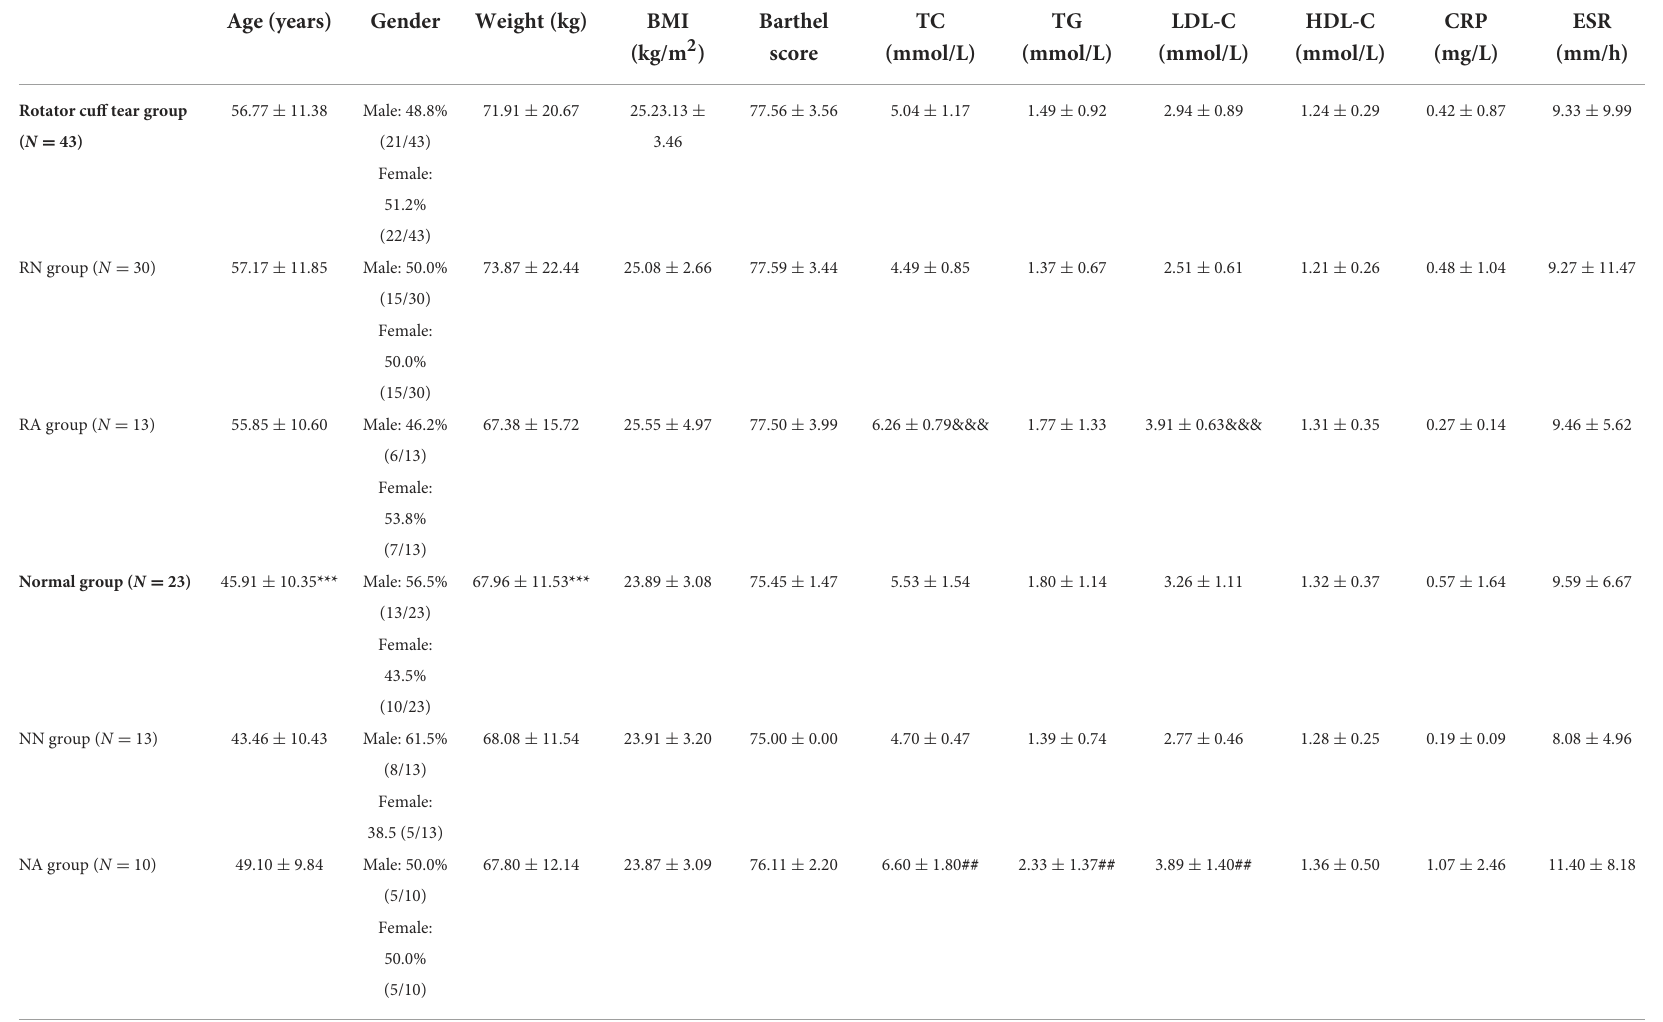
TABLE 1 Demographic and clinical parameters a of the study population. Age (years) Gender Weight (kg)